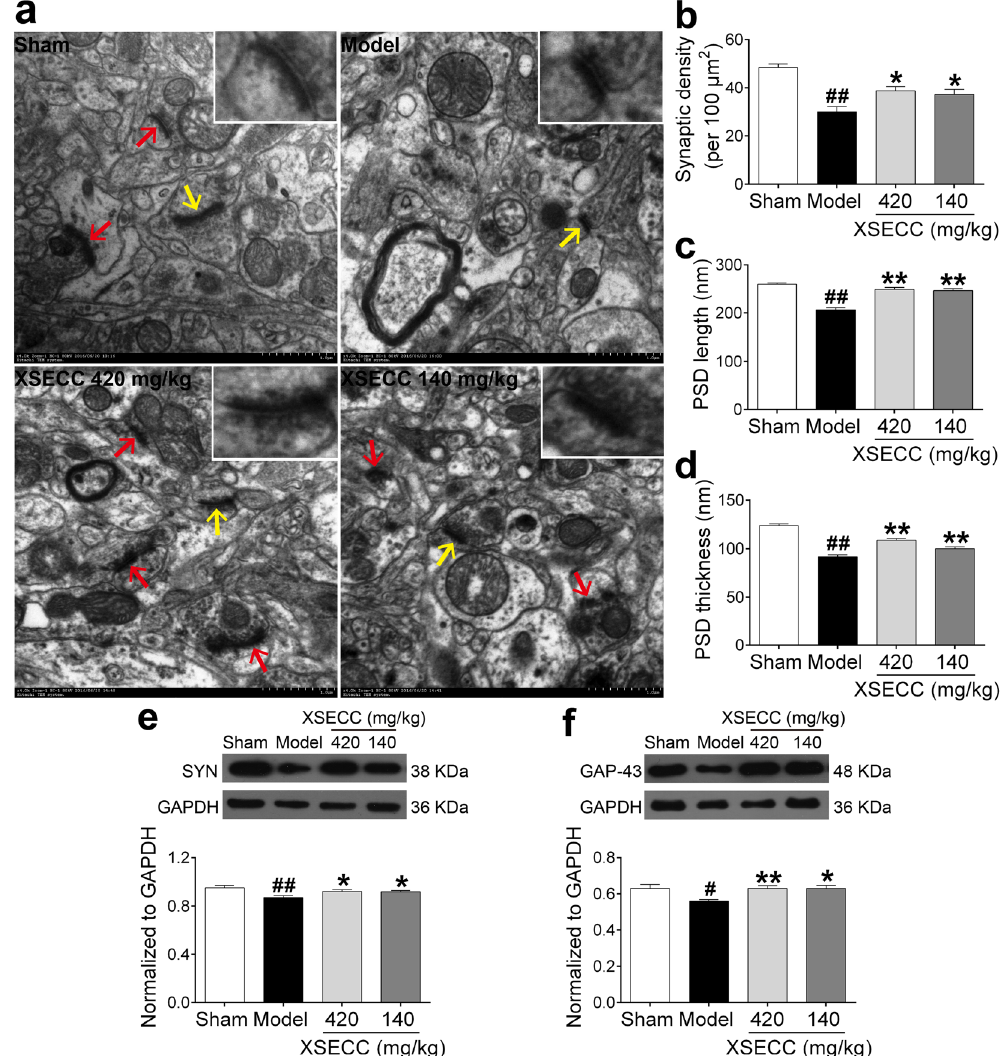
Figure 6. Effects of XSECC on neuronal plasticity in BCCAO rats. Twenty random images (8000 × ) were taken for the analysis of synaptic density and another twenty high magnification images (20000 × ) were taken for the analysis of PSD. ( a ) Typical TEM images of synaptic ultrastructure from sham, model and XSECC group rats (Scale bar = 500 nm, n = 2 per group). Synapses were identified by arrows and a magnified synapse (from the synapse indicated by yellow arrow) was displayed on the top right corner of the TEM images. Quantitation showed synaptic density ( b ), PSD length ( c ) and thickness ( d ) in the model group rats were significantly elevated by XSECC. Western blot analysis of the SYN protein expression ( e ) and GAP-43 protein level ( f ) in the hippocampus (n = 6 per group). # P < 0.05, ## P < 0.01 vs . sham group; * P < 0.05, ** P < 0.01 vs . model group (one-way ANOVA followed by LSD’s post hoc